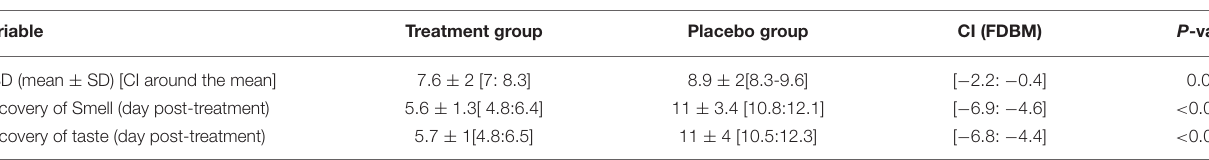
TABLE 3 | Recovery of symptoms from